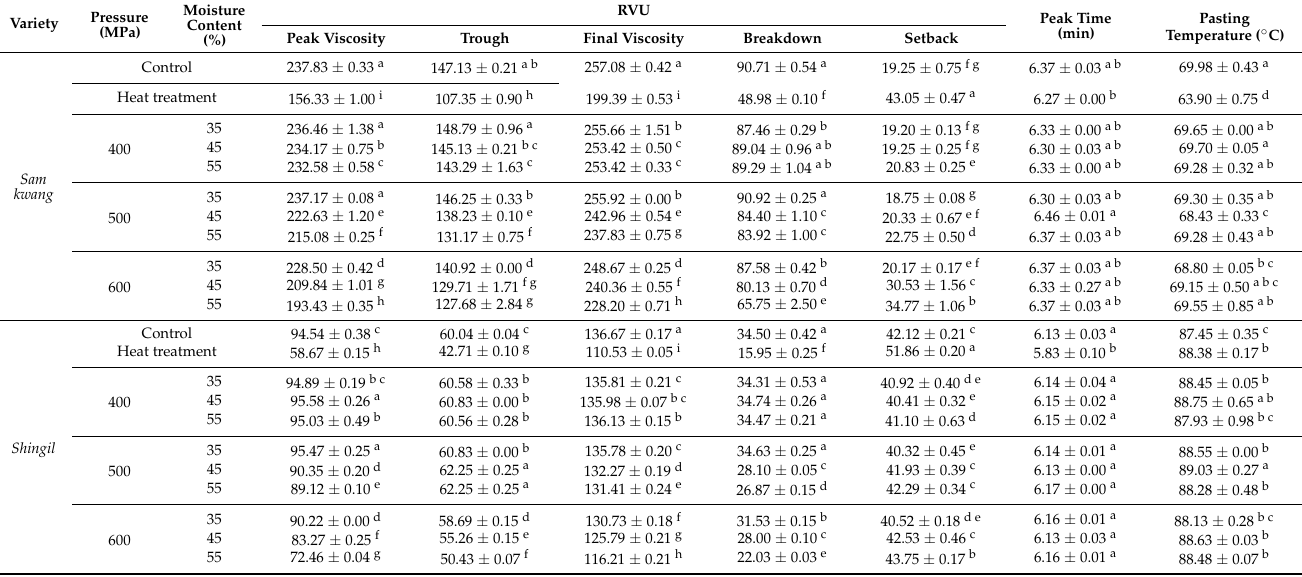
Table 1. Rapid viscosity analysis (RVA) and pasting properties of high hydrostatic pressure-treated rice flour at different moisture